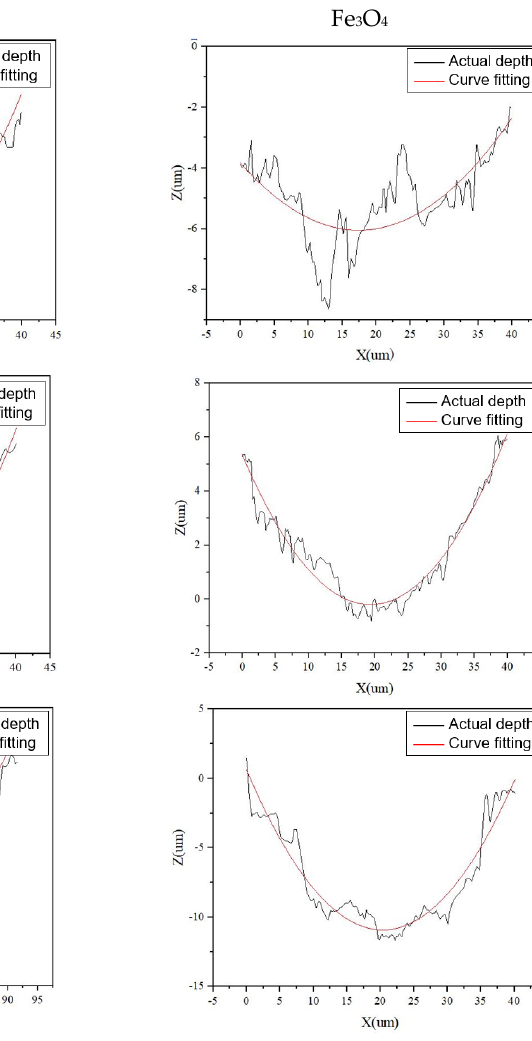
Figure 9. The groove contour after cleaning under different parameters.